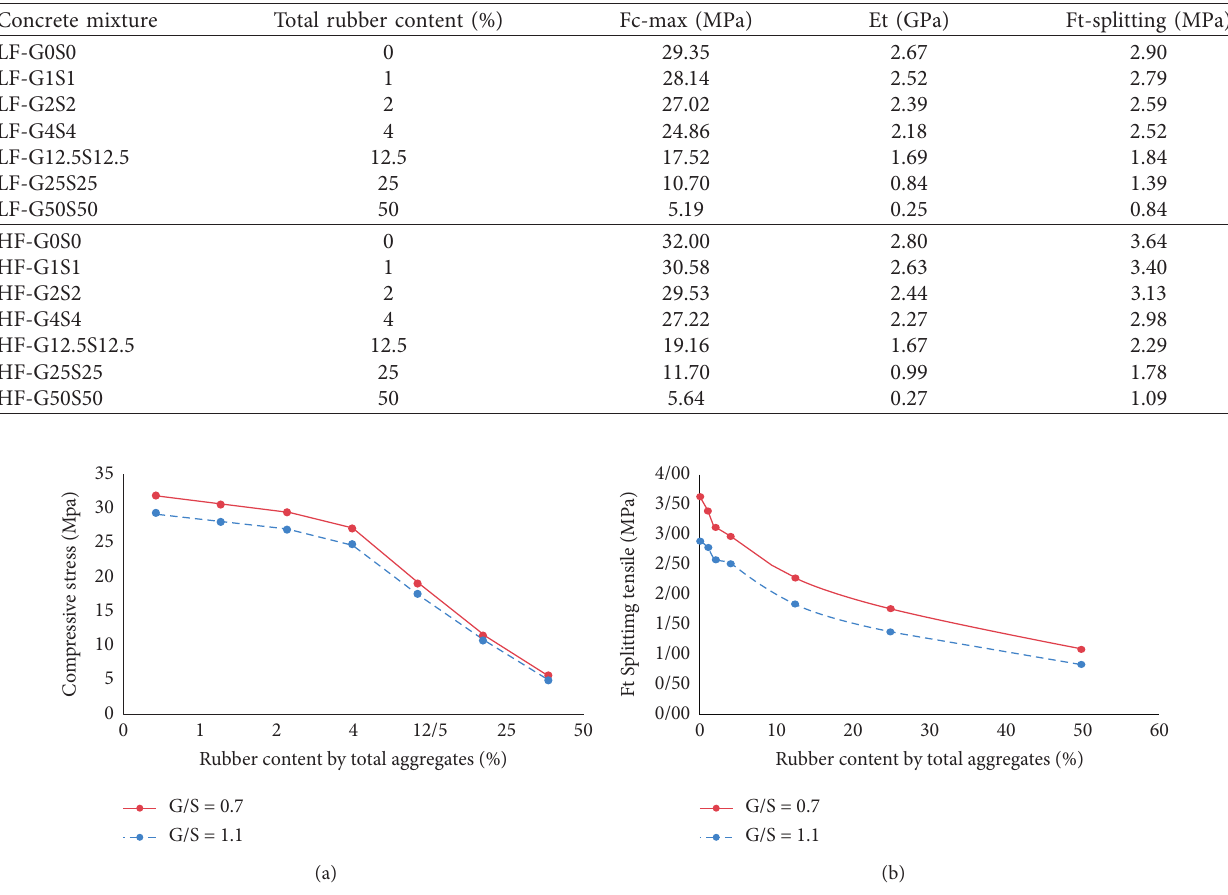
Figure 10: (a) Maximum compressive stress of HSRC specimens at 28 days. (b) Maximum tensile splitting stress of HSRC specimens at 28 days.